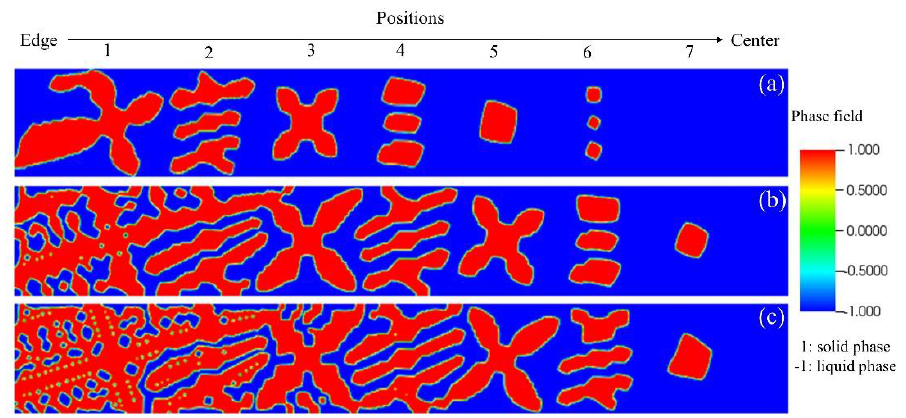
Figure 10. Simulation results about the phase-field of the three conditions with different temperature gradients at time step 300,000 Δt, ( a ) 0.230 °C/mm, ( b ) 0.442 °C/mm and ( c ) 0.657 °C/mm.